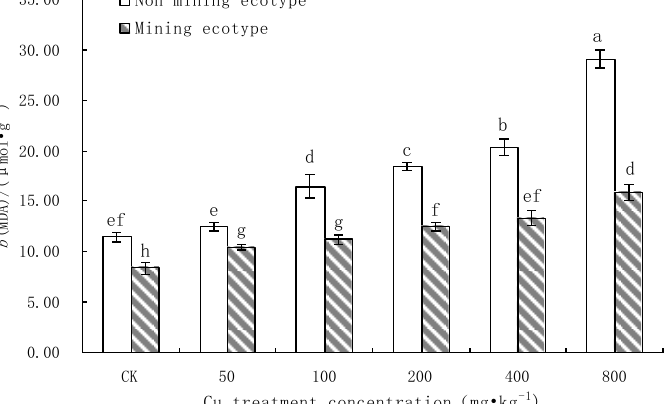
Figure 2. MDA concentrations of two ecotypes of M. floridulus under different Cu treatment. Note: Error bars indicate standard deviation; Different letters in the same group indicate significant difference at p < 0.05 according to Duncan’s multiple range tests; the same below.